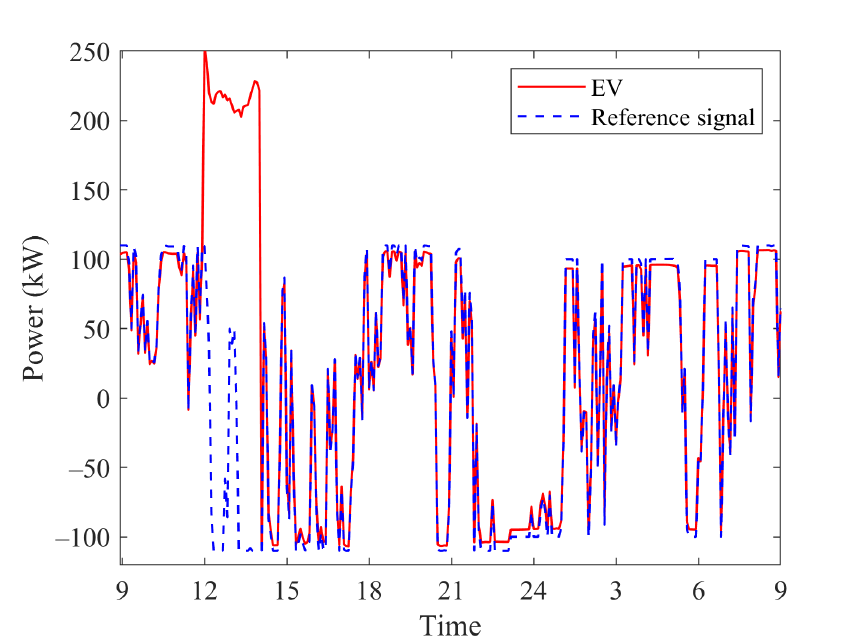
Figure 9. Aggregated EV charging and discharging profile for frequency regulation with two hours failure to the centralized optimizer from 12:00 to 14:00 in Scenario